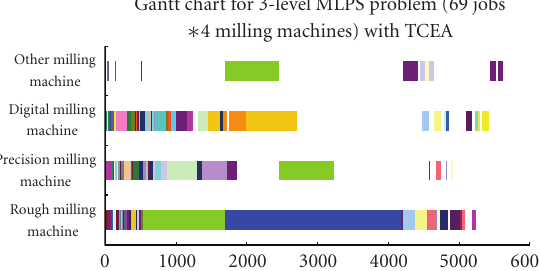
Figure 11: A typical solution of 3-level MLPS with